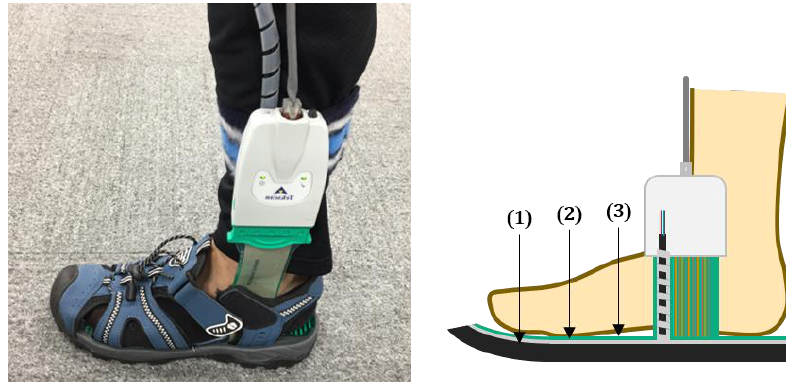
Figure 3. Picture of experimental setup. All experiments were done wearing the F-Scan system in-shoe sensor and low-cost FSR foot sensor simultaneously. (1), (2), (3) represents the shoe, developed FSR foot sensor, and the F-Scan in-shoe sensor respectively. And they are piled up in order.